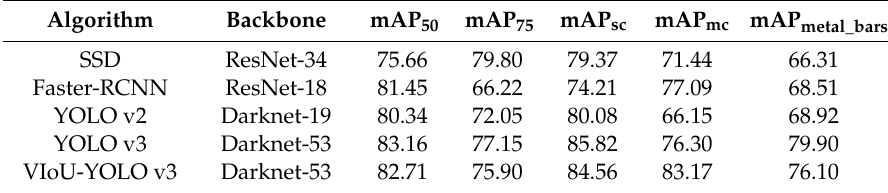
Table 1. mAP comparison with five detection